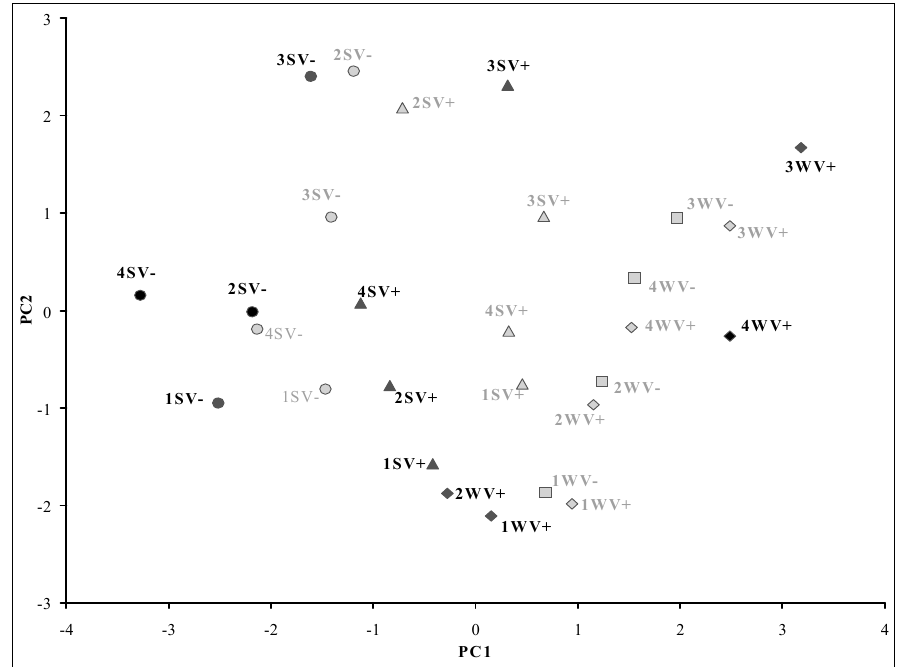
Figure 5. Score plot of the observations in the Cartesian coordinate system identified by Principal Component Analysis: analysis including variables related to carotenoids and microclimatic indexes (the variables included in the analysis are reported in Table 4). 1, 2, 3, and 4 refer to the data sampling; S—South, W—West, V + —high vigor, V − —low vigor. Symbols in black color—2012; symbols in grey color—2013; • —SouthV − , (cid:78) —SouthV + , (cid:4) —WestV − , and (cid:7) —WestV + . Prin1 and Prin2 explained, respectively, 39% and 27% of the total variance. The case